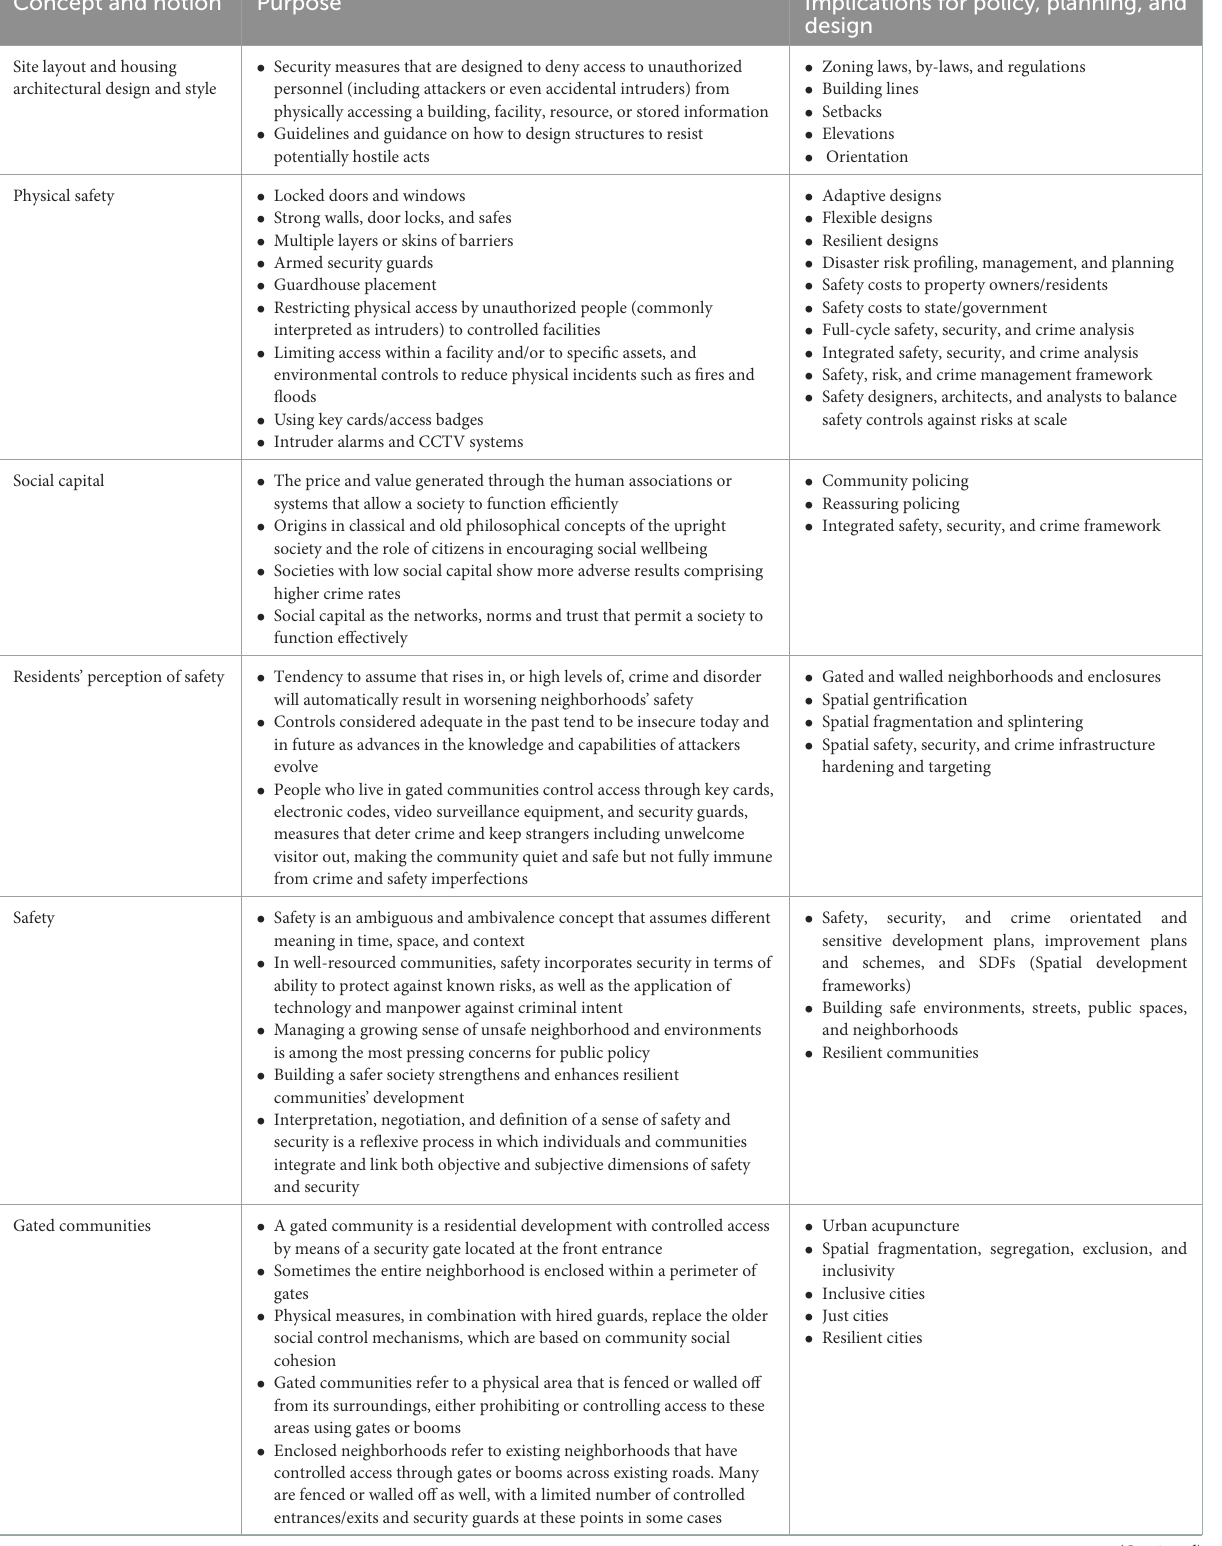
TABLE 3 Schematic literature review of representation of safety, security, and crime theoretical groundings. Concept and